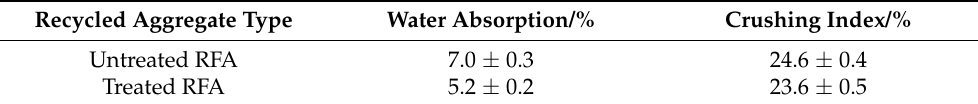
Table 2. Water absorption and crushing index of RFA before and after microbial-mineralization modification. Recycled Aggregate